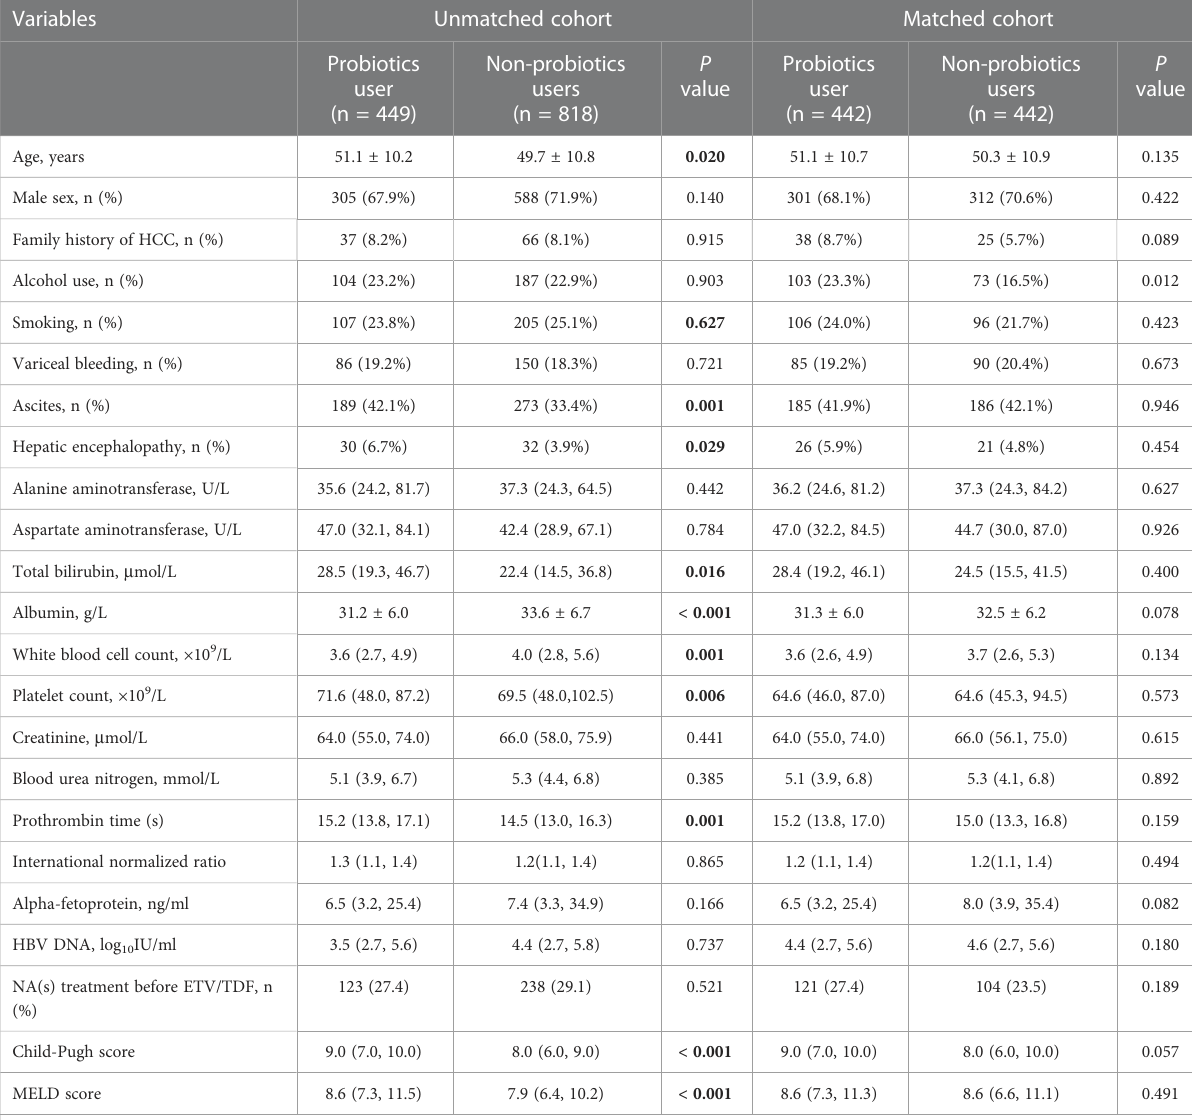
MELD, Model for End-Stage Liver Disease. Bold values: P <